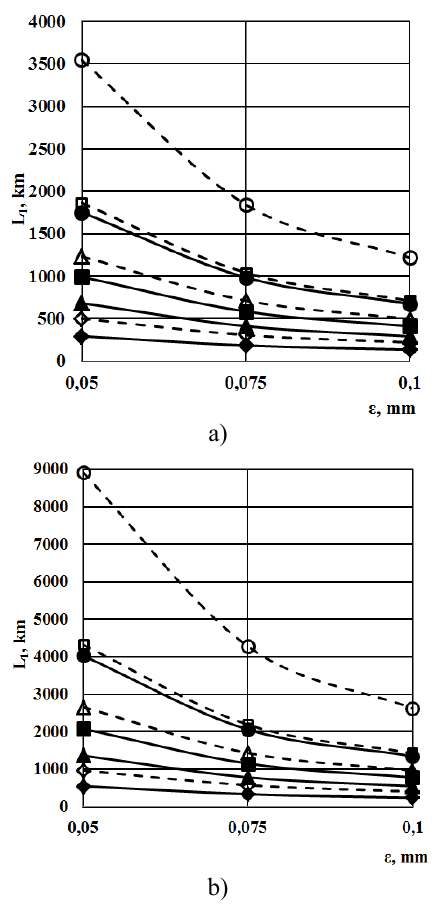
Figure 7. Dependence of the guide service life on the radial clearance